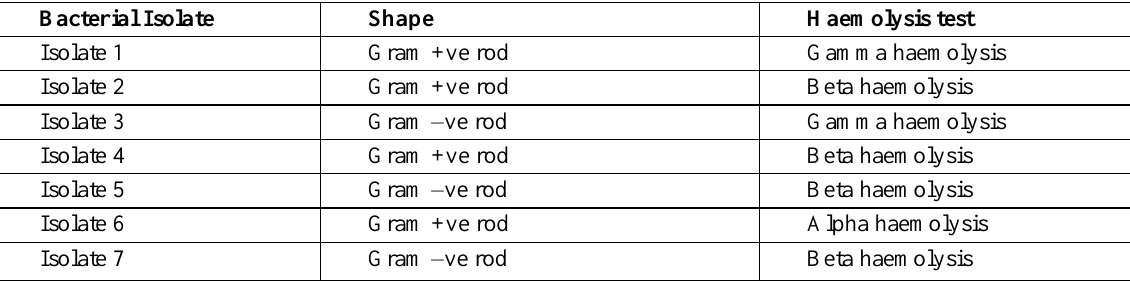
Table 1. Gram reaction of bacterial isolates and their haemolytic activity. Bacterial Isolate